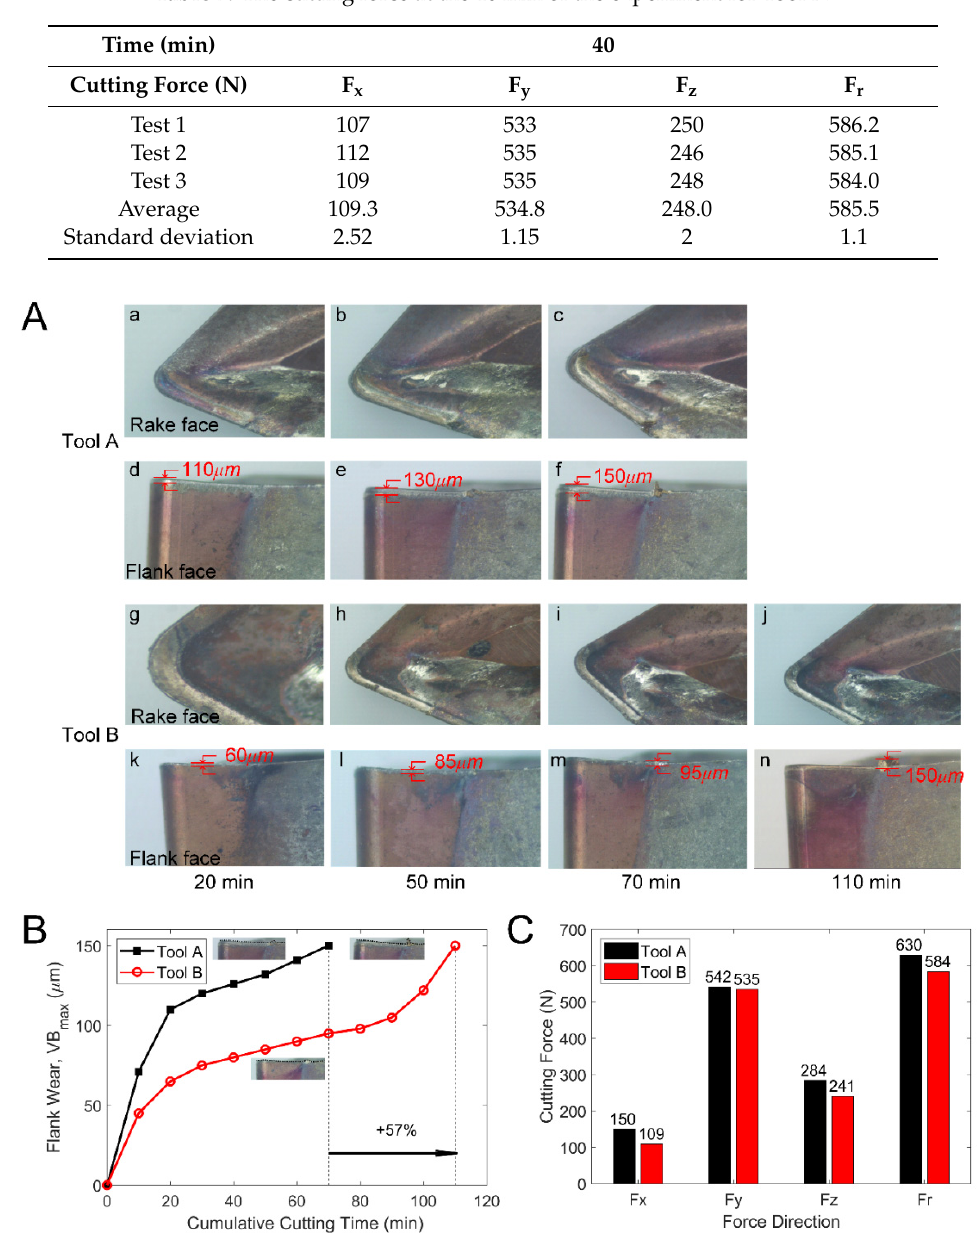
Figure 7. ( A ) The comparison of wear morphology of the rake and flank faces of the two tools. ( B ) The wear curve of the two cutting tools in processing AISI 304. ( C ) The comparison of the average cutting force and resultant cutting force of the two tools.